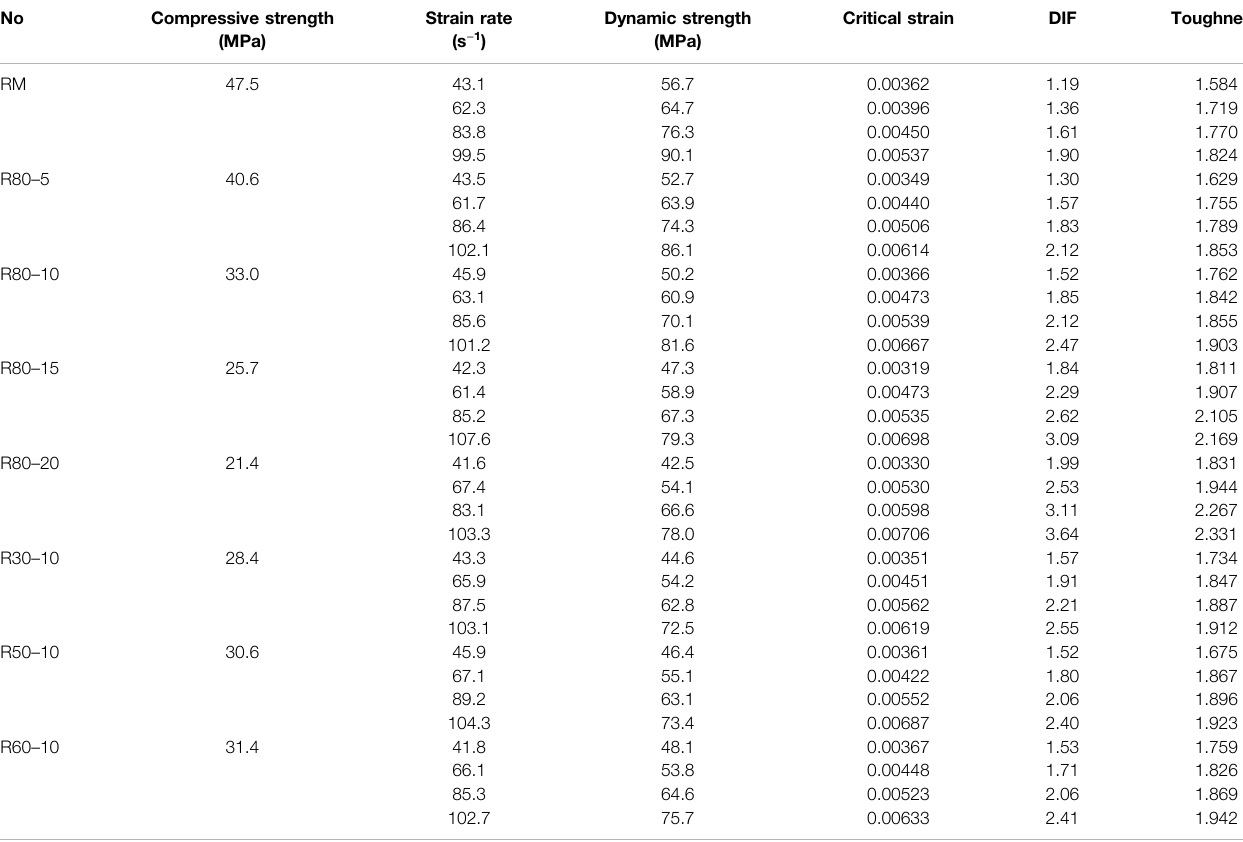
TABLE 5 | Dynamic test result of CRM.